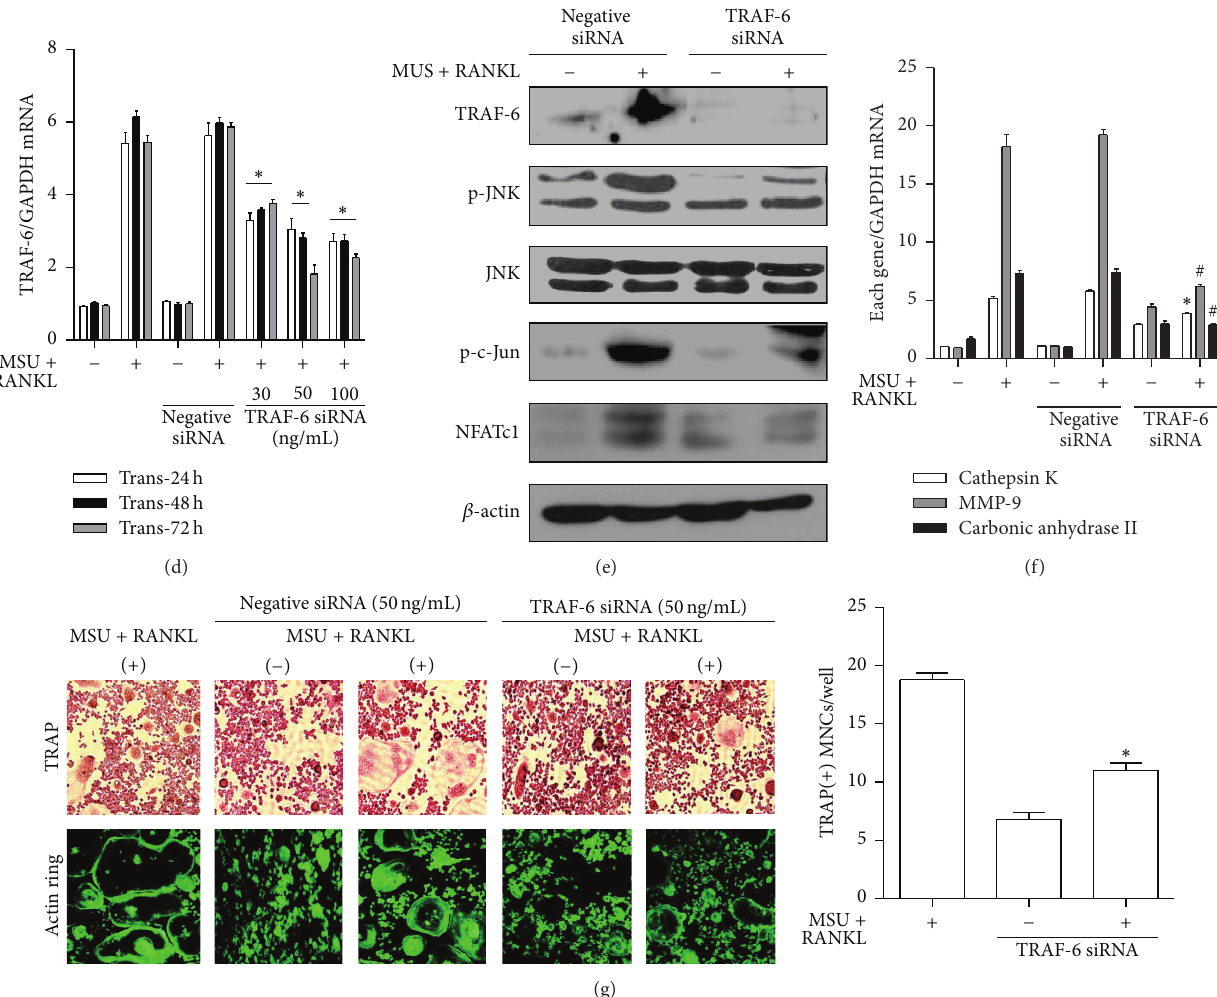
Figure 2: Induction of osteoclast differentiation through activation of TRAF-6 and JNK. (a) The protein expression of cytoplasmic molecules oftheRANKL-RANKsignalingpathwaywasassessedinRAW264.7cellsalone(controls)andexperimentalcellsincubatedwithMSUcrystals alone (0.1mg/mL), RANKL alone (100ng/mL), or both for 1h. (b) Phospho-c-Jun and NFATc1 production was measured in RAW 264.7 cells alone (controls) and experimental cells incubated with MSU crystals alone (0.1mg/mL), RANKL alone (100ng/mL), or both for 24 h. (c) The levels of phospho-c-Jun and NFATc1 protein were measured using a JNK inhibitor (SP600125), p38 inhibitor (SB203580), and ERK inhibitor (U0126) at dosages of 10 and 20 𝜇 M. (d) TRAF-6 mRNA expression was assessed in RAW 264.7 cells alone (controls) and cells transfected with negative siRNA and TRAF-6 siRNA at different dosages (0, 30, 50, and 100ng/mL) and incubation times (24, 48, and 72 h) in the presence and absence of both MSU crystals (0.1mg/mL) and RANKL (100ng/mL). ∗ 𝑝 < 0.05 and # 𝑝 < 0.05 compared to cells transfected with 0ng/mL of TRAF-6 siRNA. (e) TRAF-6, phospho-JNK, phospho-c-Jun, and NFATc1 protein levels were measured from RAW 264.7 cells transfected with negative siRNA and TRAF-6 siRNA (50 ng/mL) for 72 h. (f) The mRNA expression of osteoclast-specific genes was measured in controls and negative and TRAF-6 siRNA (50 ng/mL) RAW 264.7 cells. ∗ 𝑝 < 0.05 and # 𝑝 < 0.01 compared to cells treated with both MSU crystals and RANKL. (g) TRAP and actin ring staining assays for osteoclast-like cells were performed in control RAW 264.7 cells and TRAF-6 siRNA transfected cells under stimulation with both MSU crystals (0.1mg/mL) and RANKL (100ng/mL). ∗ 𝑝 < 0.05 compared to control cells treated with both MSU crystals and RANKL. The experimental data were determined by at least three independent